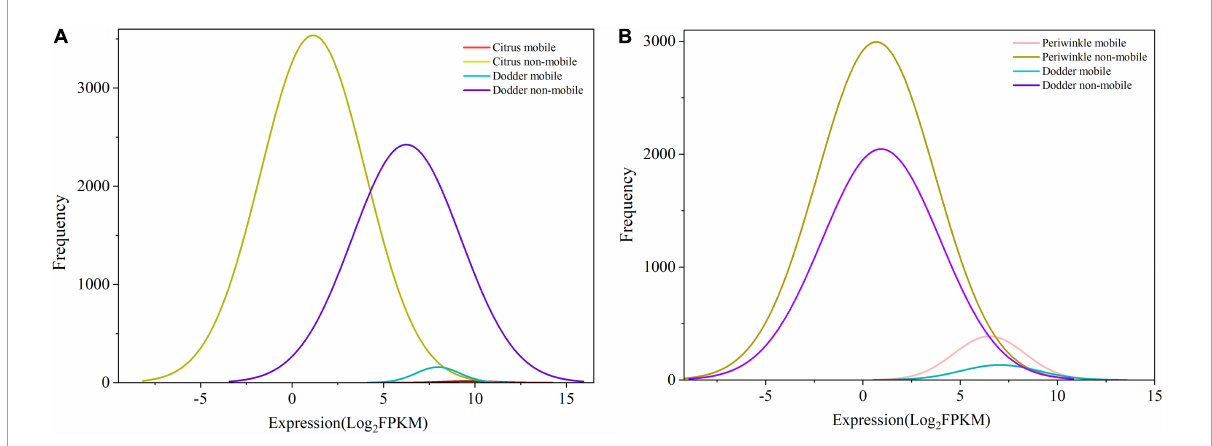
FIGURE3 Frequency and expression levels of mobile and non-mobile transcripts in different tissues. (A) Citrus-dodder system. (B) Periwinkle-dodder system. The x -axis indicated the expression level of transcript represent by Log 2 FPKM. The y -axis indicated the number of transcripts. mRNAs with mapped reads ≥ 4 were identified as mobile mRNA. mRNAs that detected in native tissue and not meeting the four reads threshold for mobility were classified as non-mobile. The diagram was generated based on quantitative transcriptomic analysis result by Origin